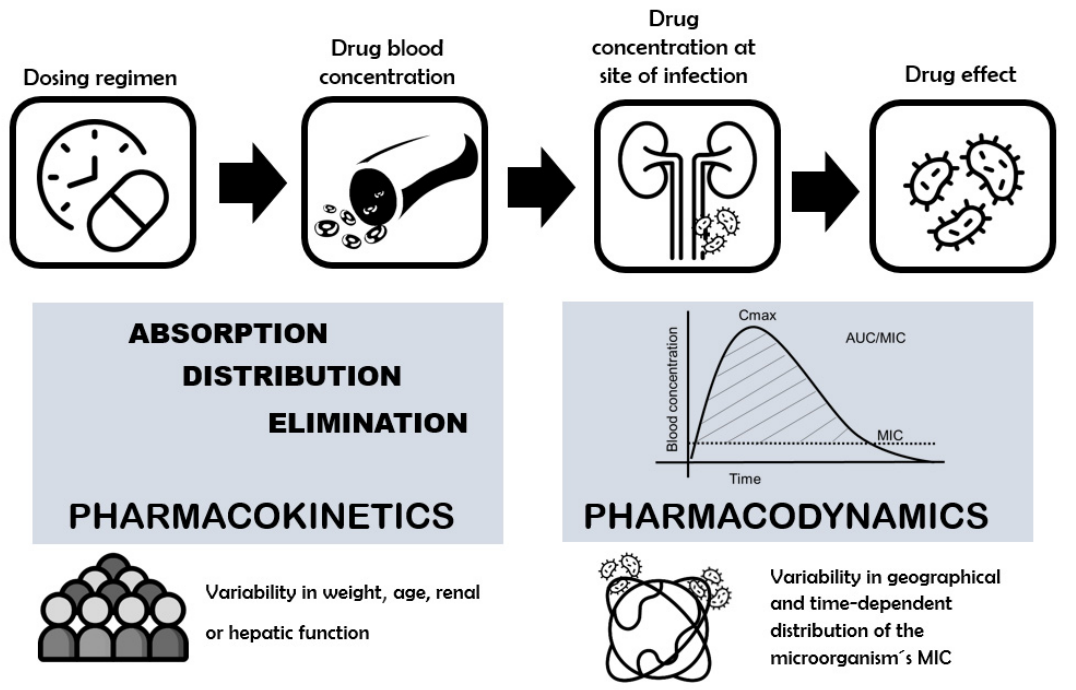
Figure 1. Pharmacokinetic/Pharmacodynamic factors affecting the dose-antimicrobial response relation. Cmax: peak plasma concentration, AUC: area under the plasma drug concentration-time curve from time, MIC: minimum inhibitory concentration of an antibiotic against a bacterial pathogen.